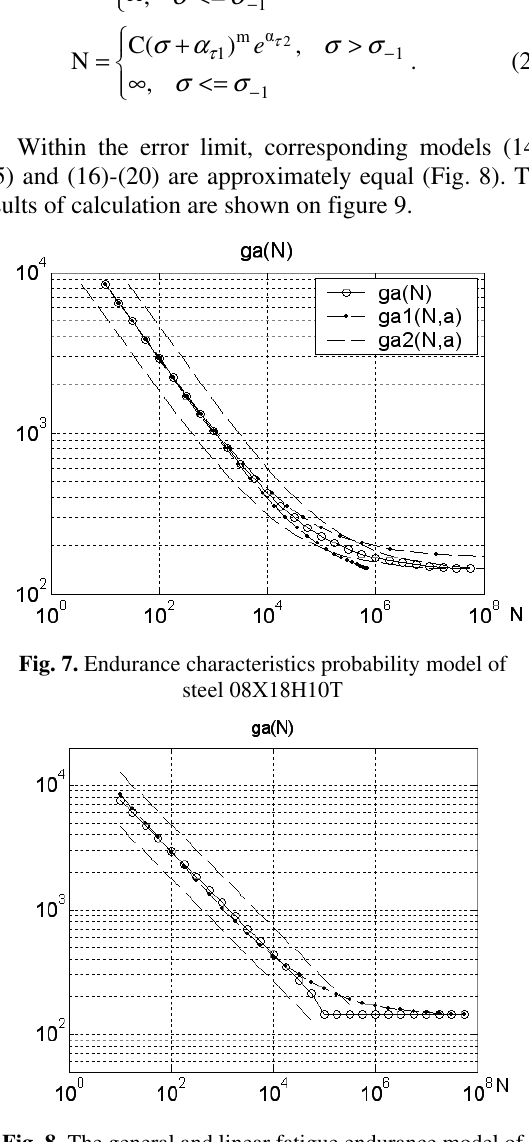
Fig. 8. The general and linear fatigue endurance model